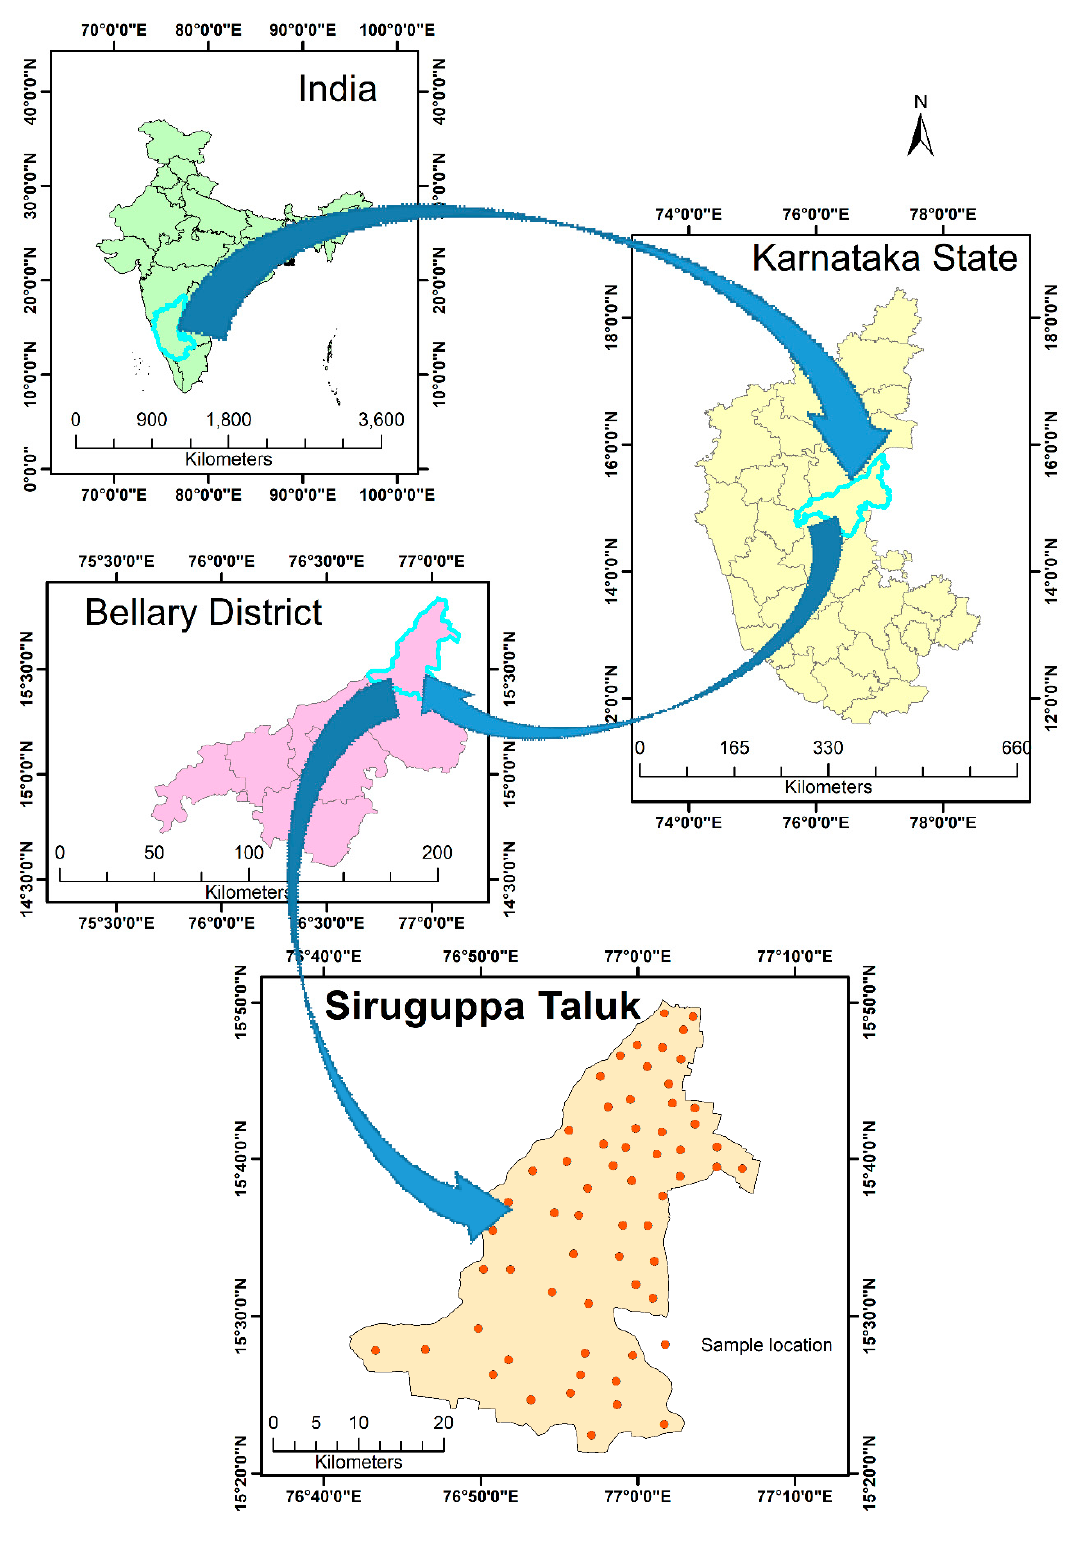
Figure 1. Map of the study area with sampling locations.